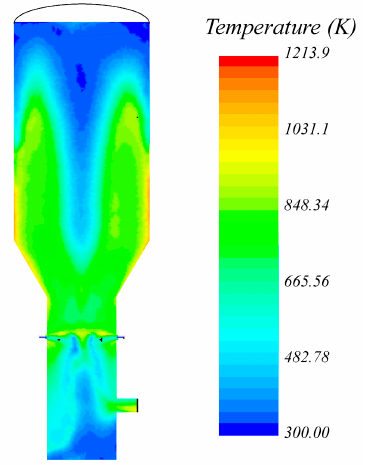
Figure 8 . Temperature profile inside the gasifier. Figure 8. Temperature profile inside the